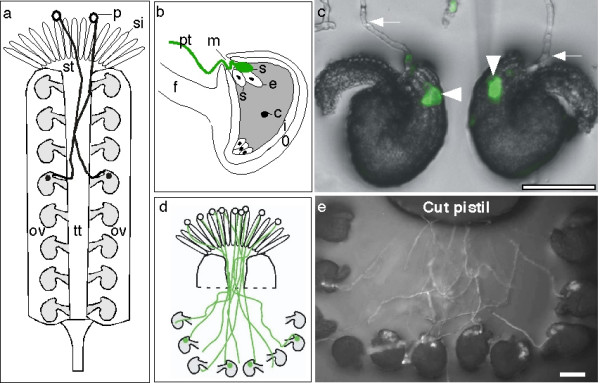
Pollen tube targeting in vitro.(a) Diagram of a pollinated pistil within an A. thaliana flower. After reaching the stigma (si), pollen (p) extends a tube through the style (st) to reach the transmitting tract (tt) before entering one of the two ovary (ov) chambers to target an ovule. (b) Upon reaching the ovule, the pollen tube (pt, green) either grows up the funiculus (f) or makes a sharp turn towards the micropyle (m) and enters the ovule. Within the ovule, the pollen tube navigates towards the female gametophyte (gray) encased by outer (o) and inner (i) integuments, lyses within one of the two synergid (s) cells that flank an egg cell (e). Upon lysis, one sperm fertilizes the egg cell to form the zygote and the other fuses with the central cell (c) to form the endosperm. The number of pollen tubes drawn is for illustration purposes only and does not reflect the quantity typically observed in an assay. (c) Merged fluorescent and bright field images depicting the final stages of in vitro pollen tube growth. GFP-tagged pollen tubes make a committed turn (arrows) before entering a virgin ovule and lysing (arrow heads). (d) Diagram and (e) merged fluorescent and bright field image of in vitro pollen tube guidance assay. Pollen tubes emerge from the cut portion of the pistil, travel across the agarose medium before entering the excised ovules. Fluorescent green spot within ovules mark successful pollen tube targeting. Scale bars, 100 μm.